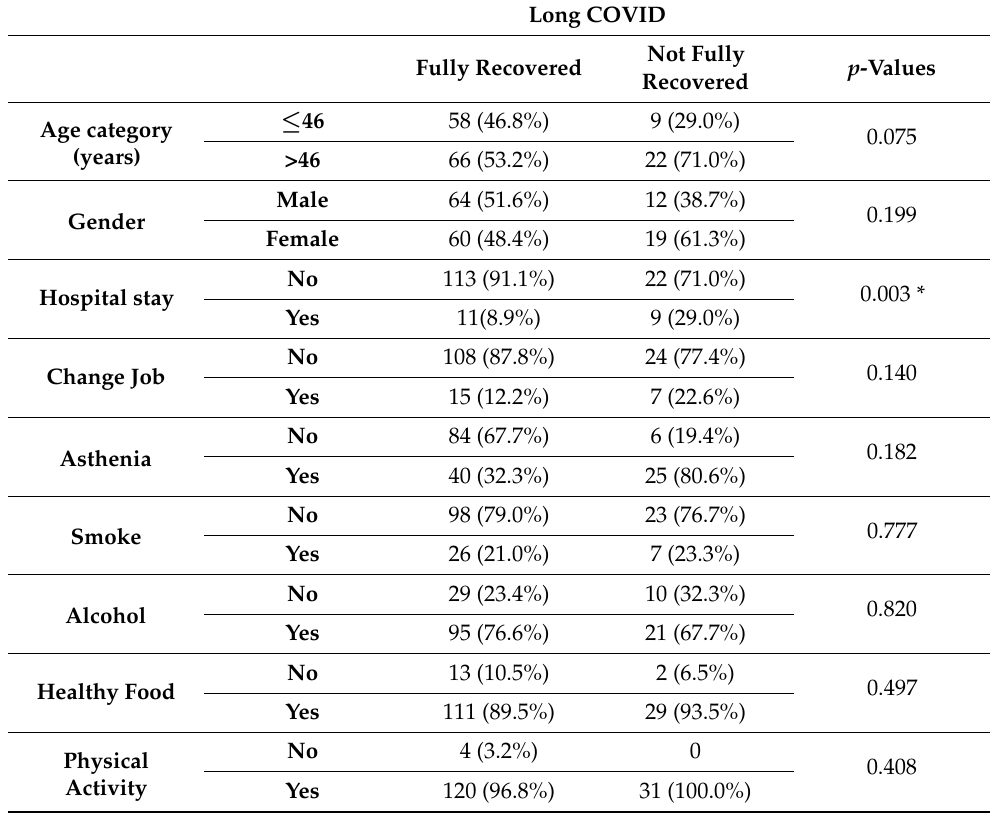
Table 2. Chi-square test correlating patients’ recovery with age, gender, hospital stay, change in job, asthenia, and modifiable risk factors (* p ≤ 0.05).